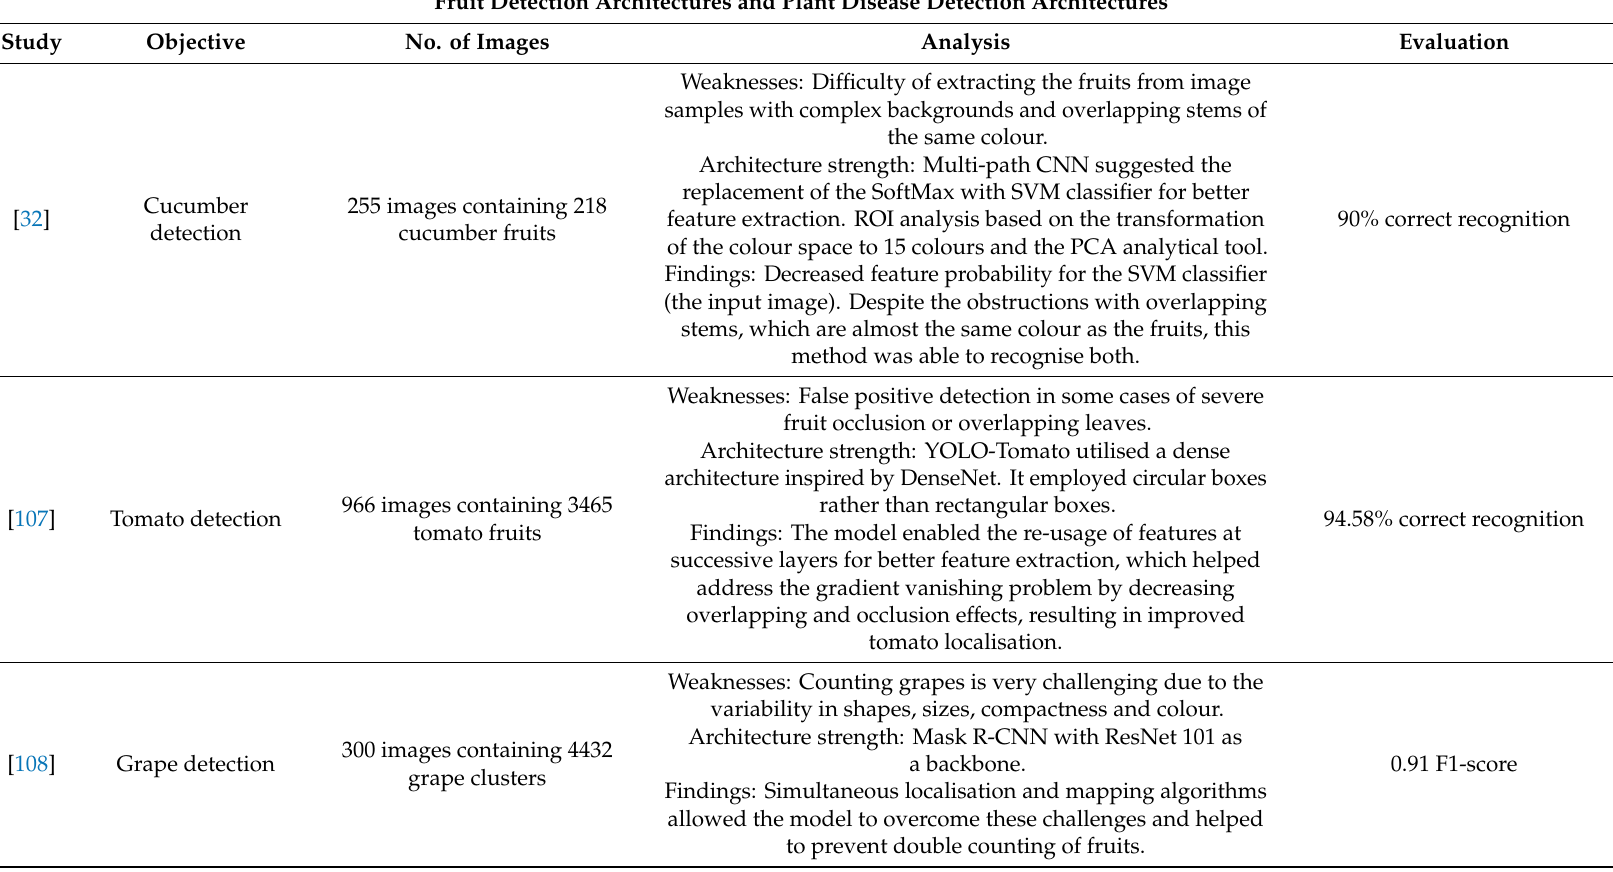
Table 1. Analysis of recent studies in crop, pest and disease detection using deep learning (DL) techniques. (Weaknesses = challenges facing researchers; Architecture strength = how these challenges are handled; and Findings = the results of the